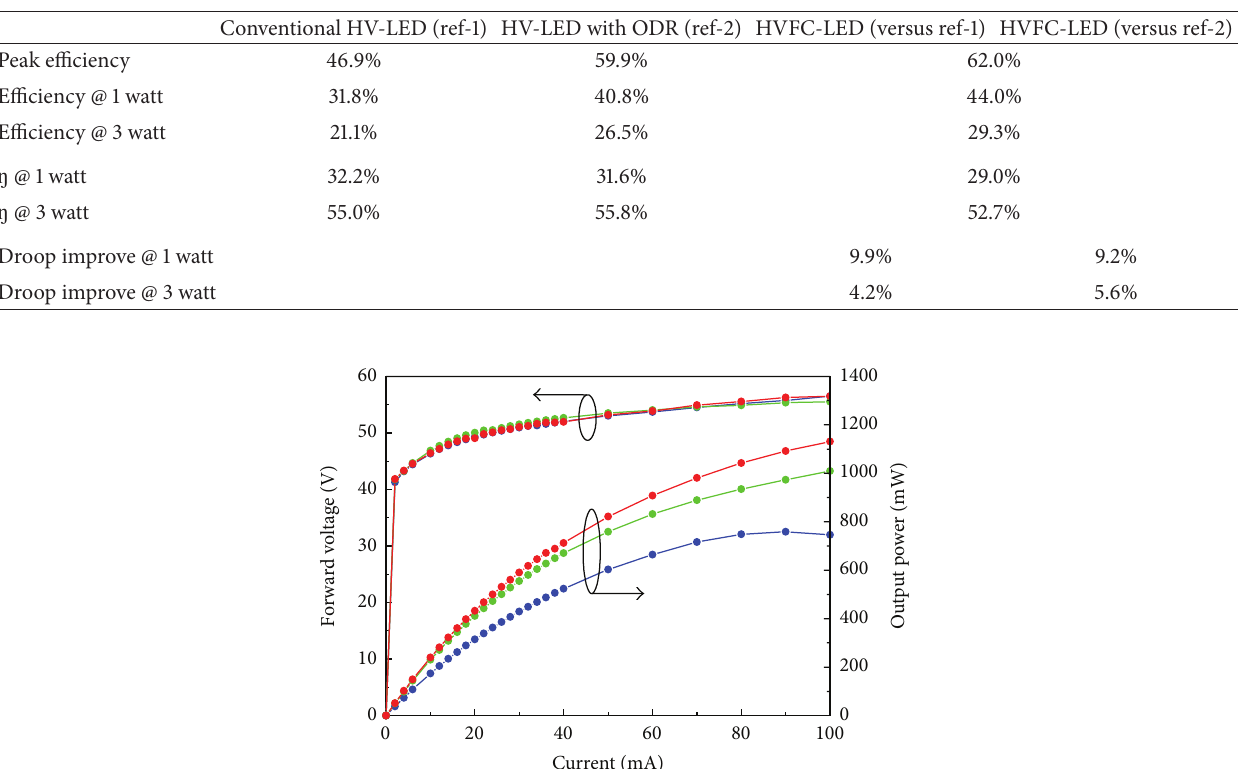
Table 2: The wall plug efficiency comparison of three kinds of LED.